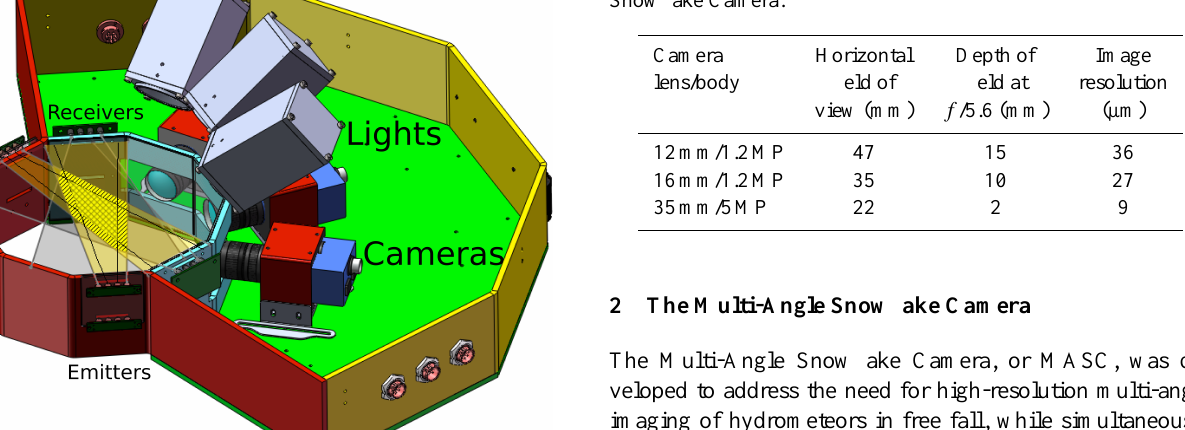
Table 1. Lens and camera parameters for the Multi-Angle Snowflake